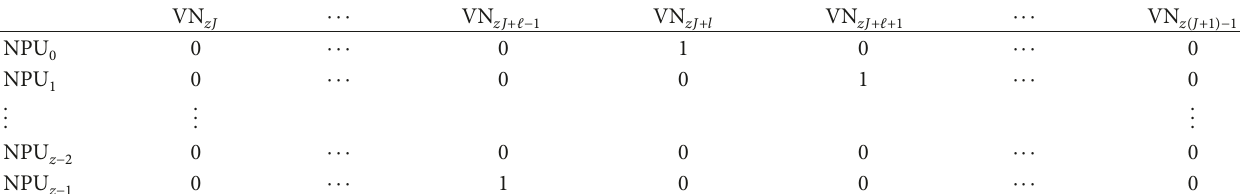
Table 2: Arbitrary submatrix I 𝑠 in H , 0 ≤ 𝐽 ≤ 𝑛 𝑏 − 1 , illustrating the opportunity to parallelize 𝑧